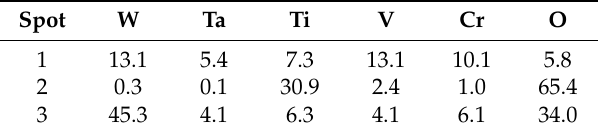
Table 2. EDS analysis of W 0.5 (TaTiVCr) 0.5 alloy in Figure 3 after in-situ XRD measurement at 1400 °C in at. %.